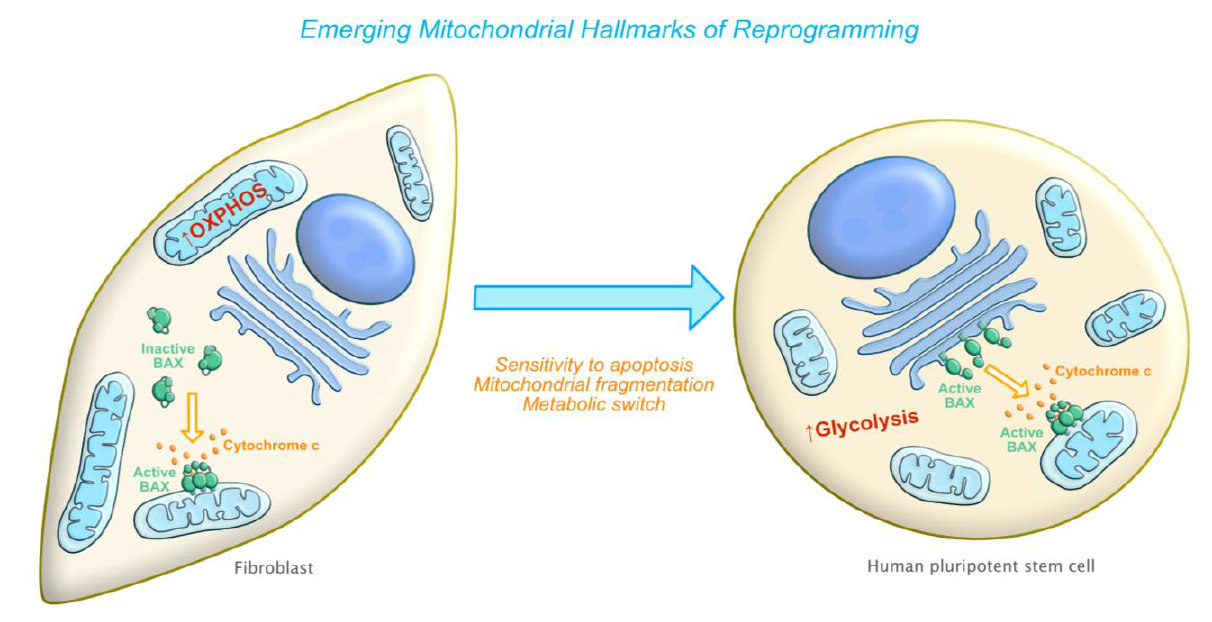
FIGURE 1: Emerging mitochondria-related hallmarks of reprogramming. Left side: Differentiated cells (such as fibroblasts) have an elon- gated mitochondrial network with a preference for oxidative phosphorylation (OXPHOS) as a source of energy and are relatively resistant to apoptosis stimuli. Right side: After reprogramming, cells now have a fragmented mitochondrial network with a switch to using glycolysis as a preferred bioenergetic source. Cells become increasingly sensitive to cell death due to at least two main mechanisms: increased mito- chondrial priming and pre-activated